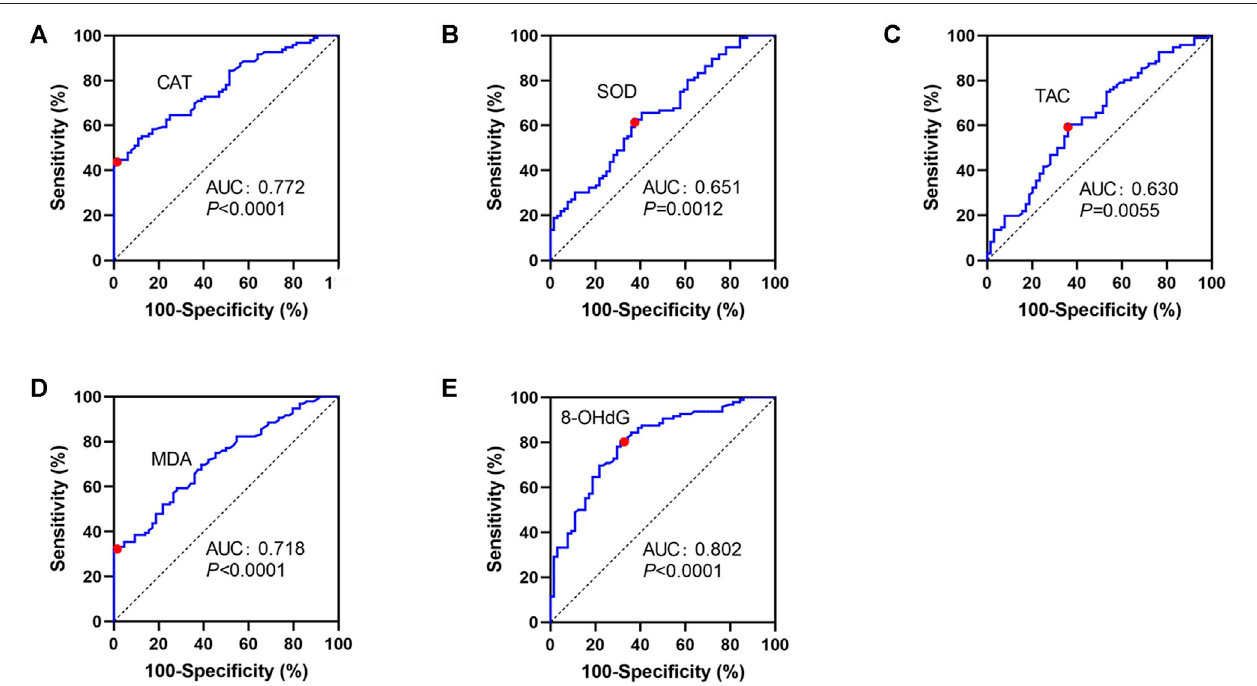
FIGURE 1 | ROC curves for CAT (A) , SOD (B) , TAC (C) , MDA (D) , and 8-OHdG (E) in patients with NSV and HC. ROC, receiver operating characteristic curves; CAT,catalase;SOD,superoxidedismutase;TAC,totalantioxidantcapacity;TEAC,Troloxequivalentantioxidantcapacity;MDA,malondialdehyde;8-OHdG,8-hydroxy-